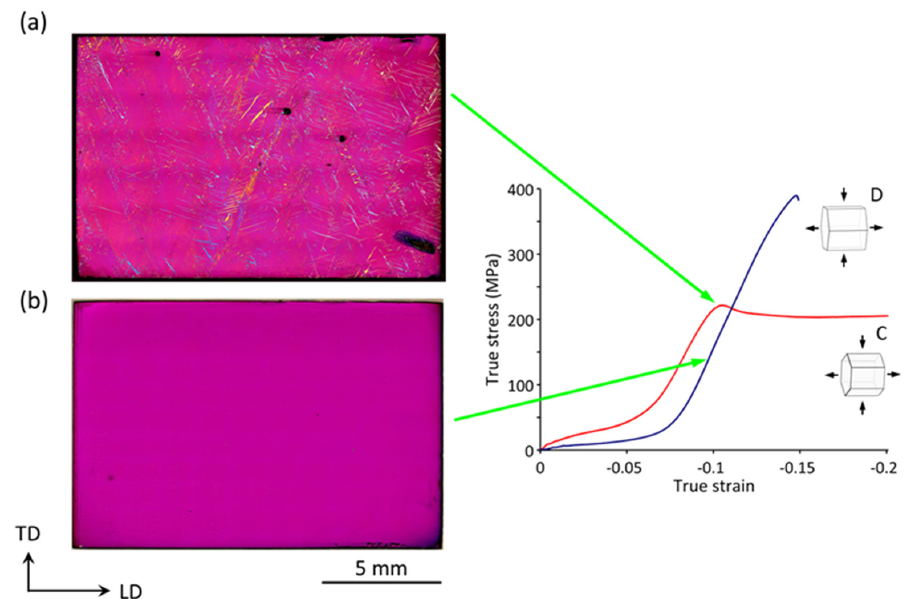
Figure 12. Optical micrographs of the whole specimen mid-thickness plane after PSC tests at room temperature of crystals with ( a ) orientation C at a true strain of − 11% and ( b ) orientation D at a true strain of − 10.5%.